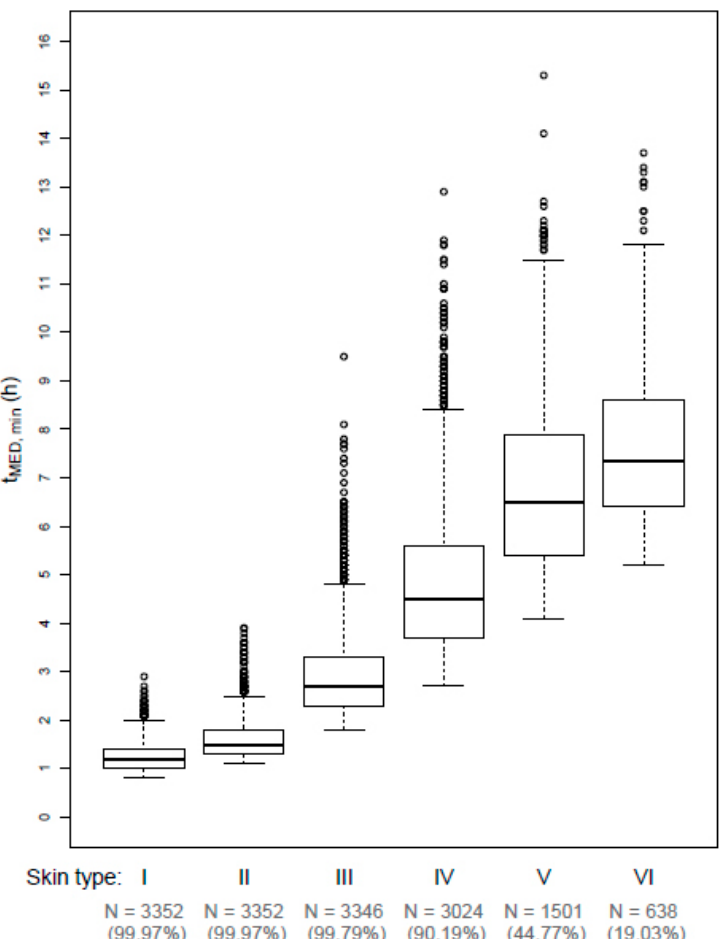
Figure 4. Boxplots of daily minimum exposure durations (in hours) needed to receive one MED (t MED, min ) for skin types I–VI for days with rounded UVI values of 2. Bold line: median, lower / upper edge of box: 25% / 75% quantile (first / third quartile), whiskers: range of data points which are no more than 1.5 times the interquartile range out of the box, dots: outliers. N (%) denotes the absolute (relative) number of observations in the subsample, i.e., the absolute (relative) number of UVI 2 days for which one MED could actually be received. The trend in t MED,min with respect to skin type can be considered significant ( p < 0.001).